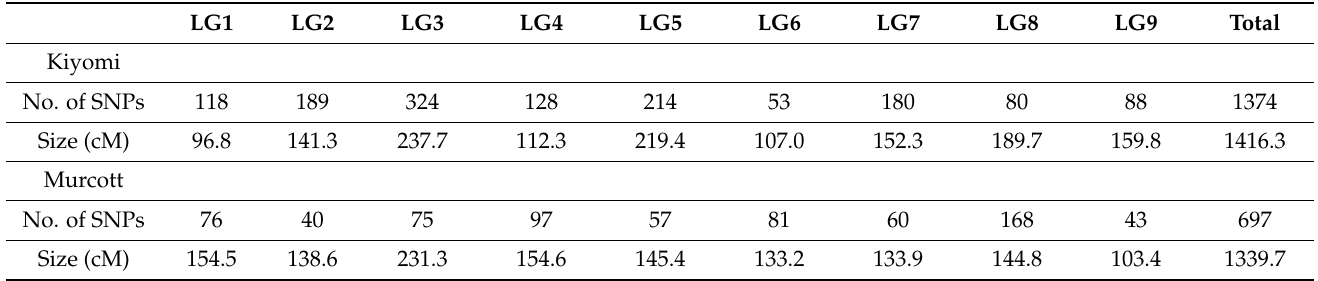
Table 1. Summary of ‘Kiyomi’ and ‘Murcott’ tangors mapping